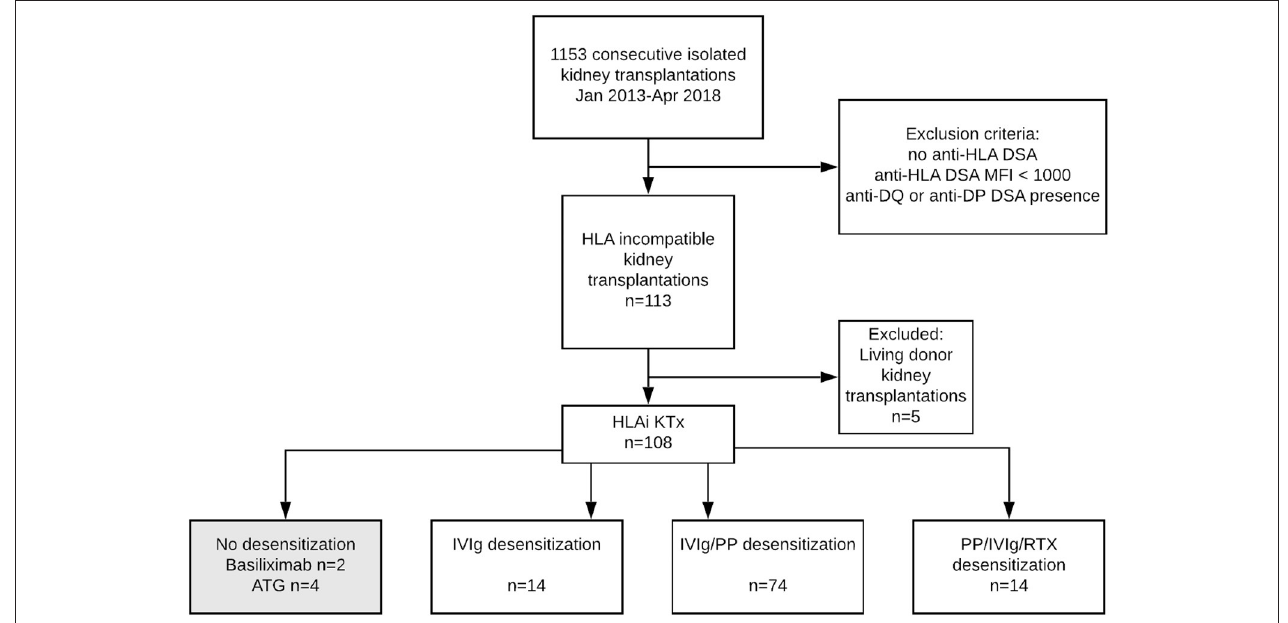
FIGURE 1 | Flow diagram of kidney transplant recipients included in the study and study cohort’s definition. DSA, Donor-specific Antibodies; HLA, Human Leukocyte Antigen; KTx, Kidney Transplantation; ATG, Antithymocyte Globulin; IVIg, Intravenous Immunoglobulin; PP, Plasmapheresis; RTX,